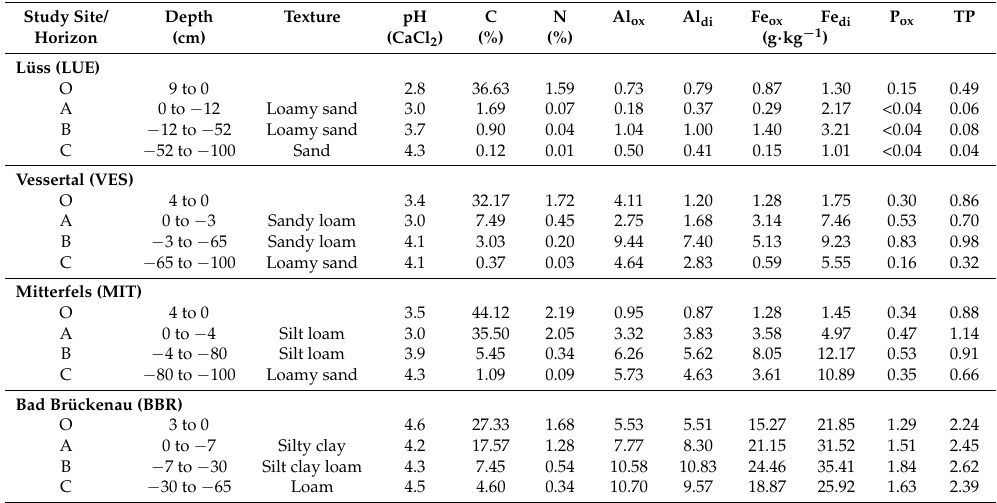
Table 2. Soil properties at four study sites in beech forests in Germany.